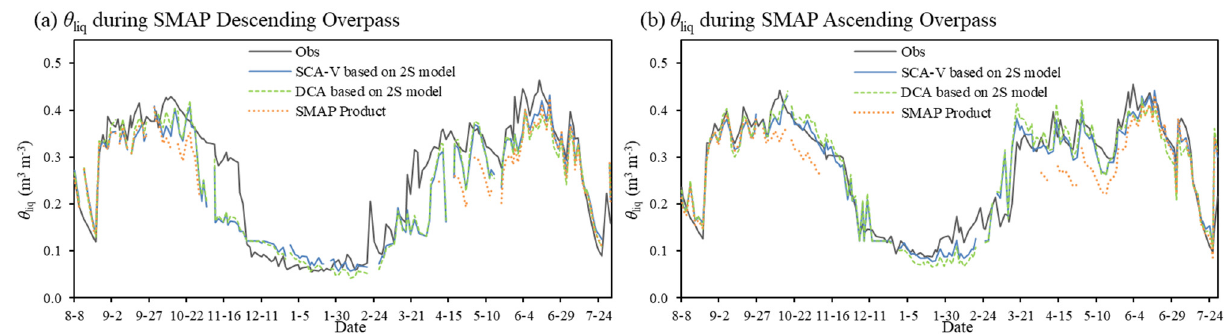
Figure 6. Time series of θ liq measurements and retrievals obtained by the SCA-V and DCA based on the improved two-stream (2S) microwave emission model using the SMAP T B p measurements during the ( a ) descending and ( b ) ascending overpasses. The values derived from the SMAP SM products are also shown. The figure is modified from Wu [45].